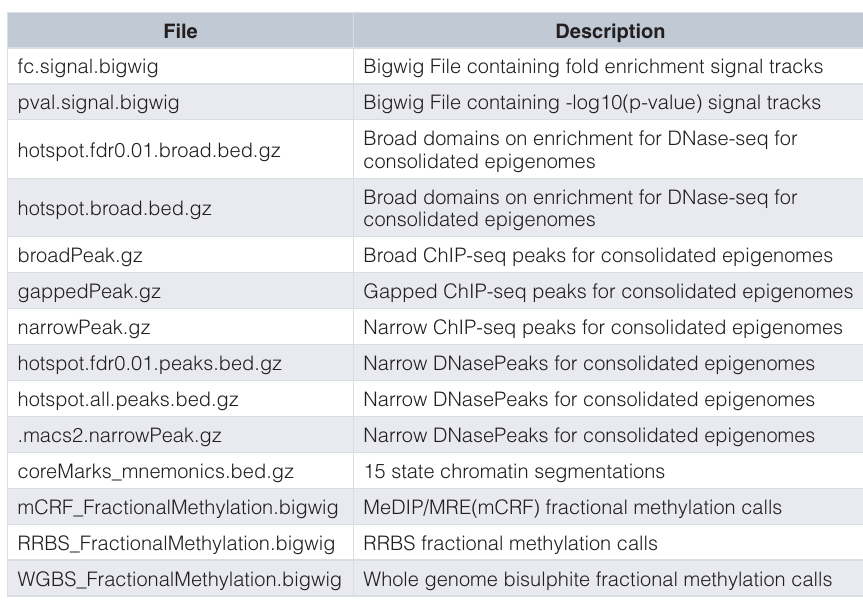
Table 5. ChIP-seq data file types available in